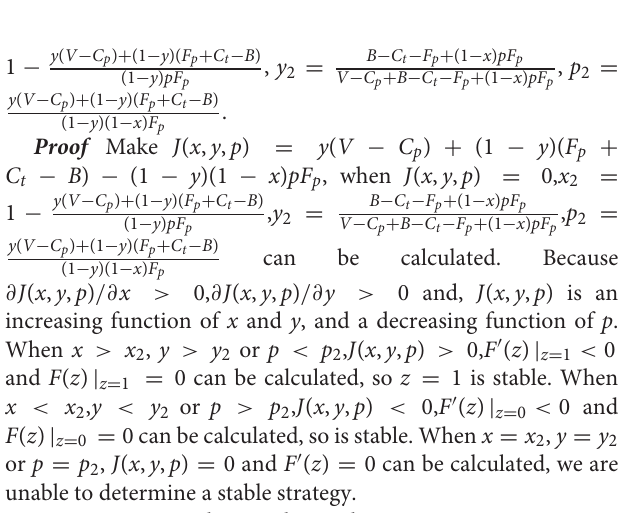
FIGURE 3 | Phase diagram of drug enterprises strategic choice. Figure is the phase diagram that shows the evolutionary trend of drug enterprises’ strategy obtained by calculating the response function of the probability of drug enterprises choosing the “producing high-quality drug”